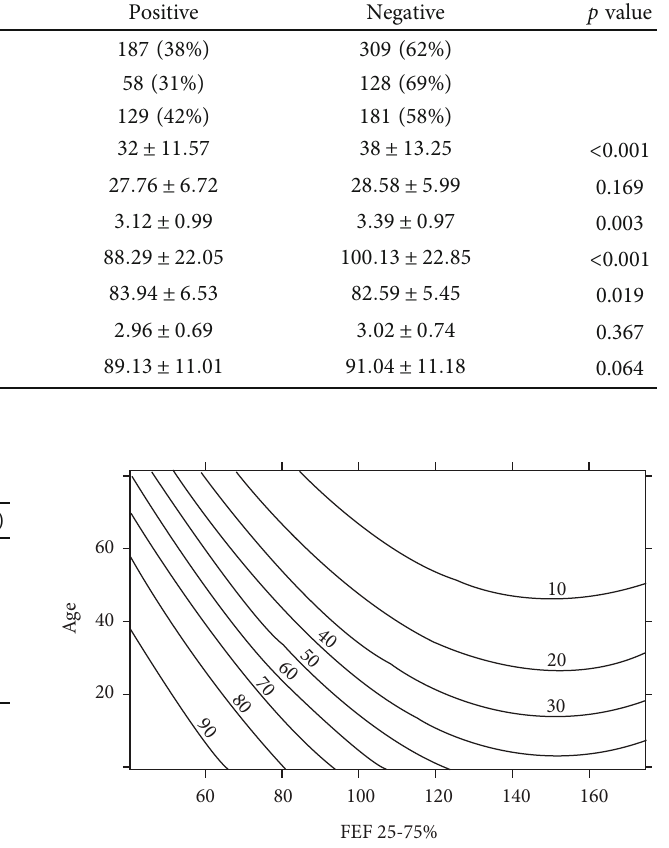
Figure 1: Probability of positive methacholine test contour graph: age by FEF% predicted